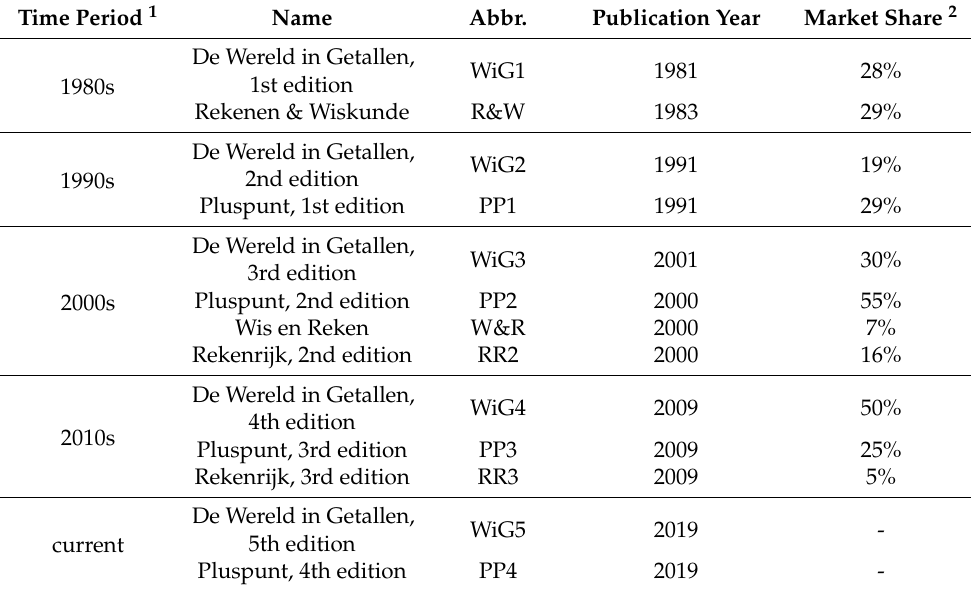
Table 2. Textbook series included in Study